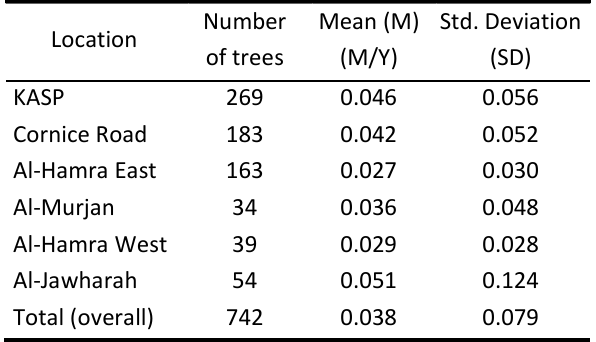
Table 2: Means and standard deviations of deformation growth according to trees’ages and locations Figure 5: Distribution of palm trees‘ trunks deformation positions within the study area, where majority occurred along the bottom third of the truck.